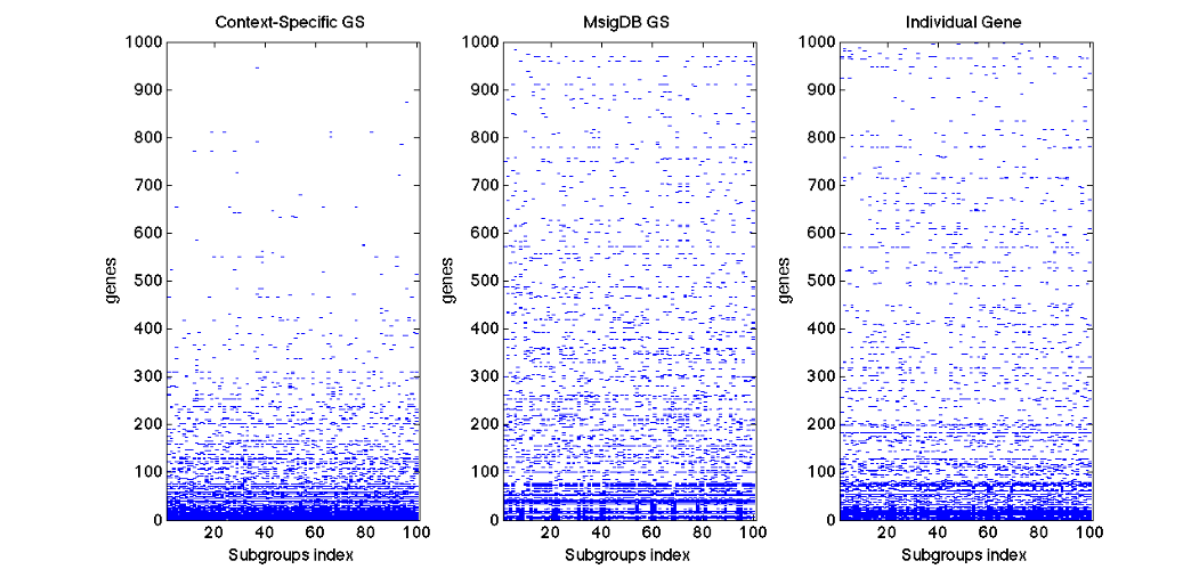
Figure 7: Comparison of the robustness in features selection for the classifier based on CSGS, MSigDB and individual gene. The x-axis represents different tests, and y-axis represents the rank of features in each test, as compared to the rank from the first